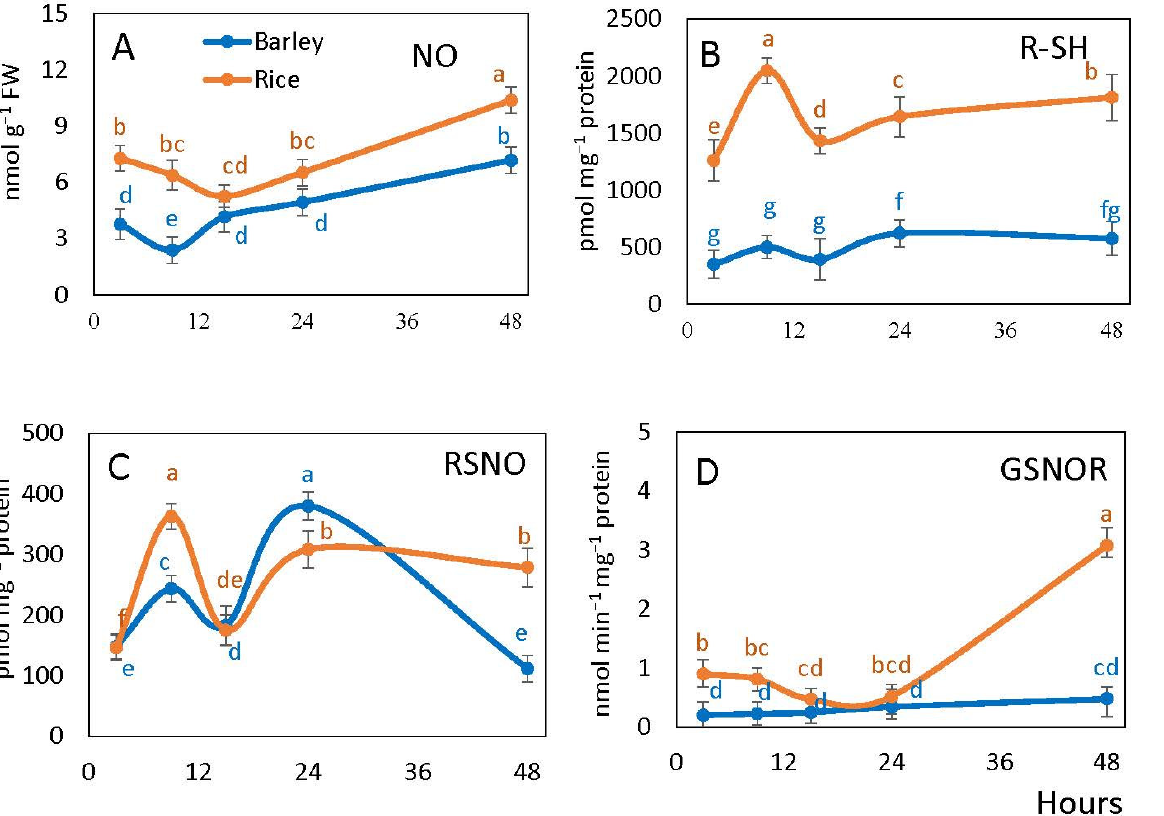
Figure 3. Levels of NO ( A ), free thiols (R-SH) ( B ), S -nitrosylation (RSNO) ( C ) and S -nitrosoglutathione (GSNOR) activity ( D ) in barley and rice embryos following imbibition. Vertical bars represent standard deviations ( n = 3). Different letters indicate significant differences between the two species and the time points at p < 0.05, (one-way ANOVA test, Tukey comparison).